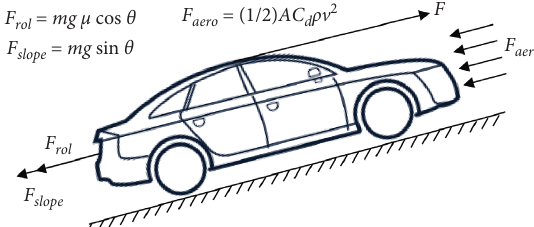
Figure 1: The diagram of vehicle longitudinal